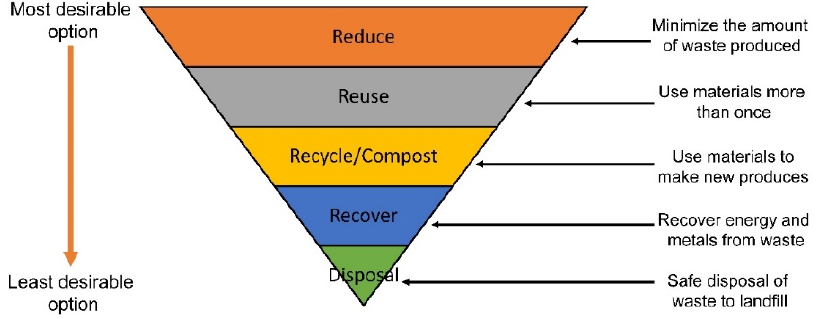
Figure 4. The global waste management hierarchy [29].